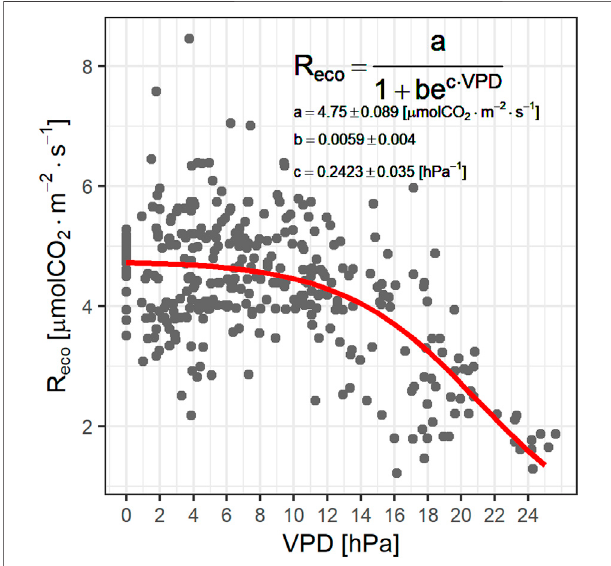
FIGURE 8 | Relationship between ecosystem respiration and VPD. Coef fi cient uncertainties are ± 1 standard deviation (68%